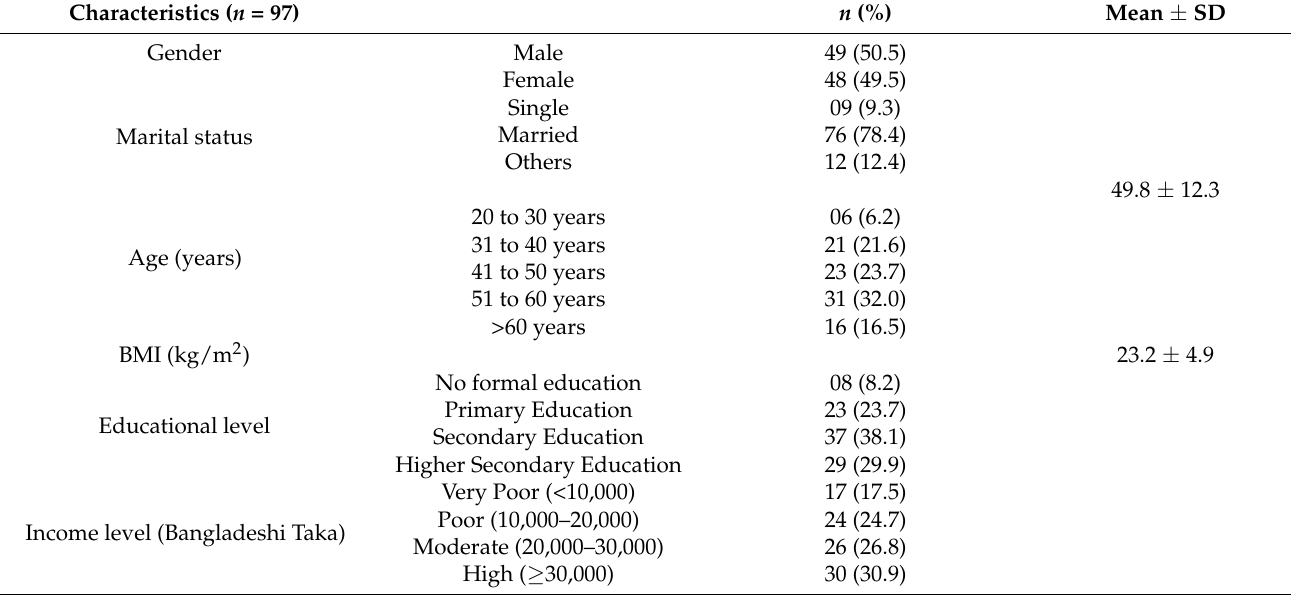
Table 2. Socio-demographic characteristics and clinical data of Phase III